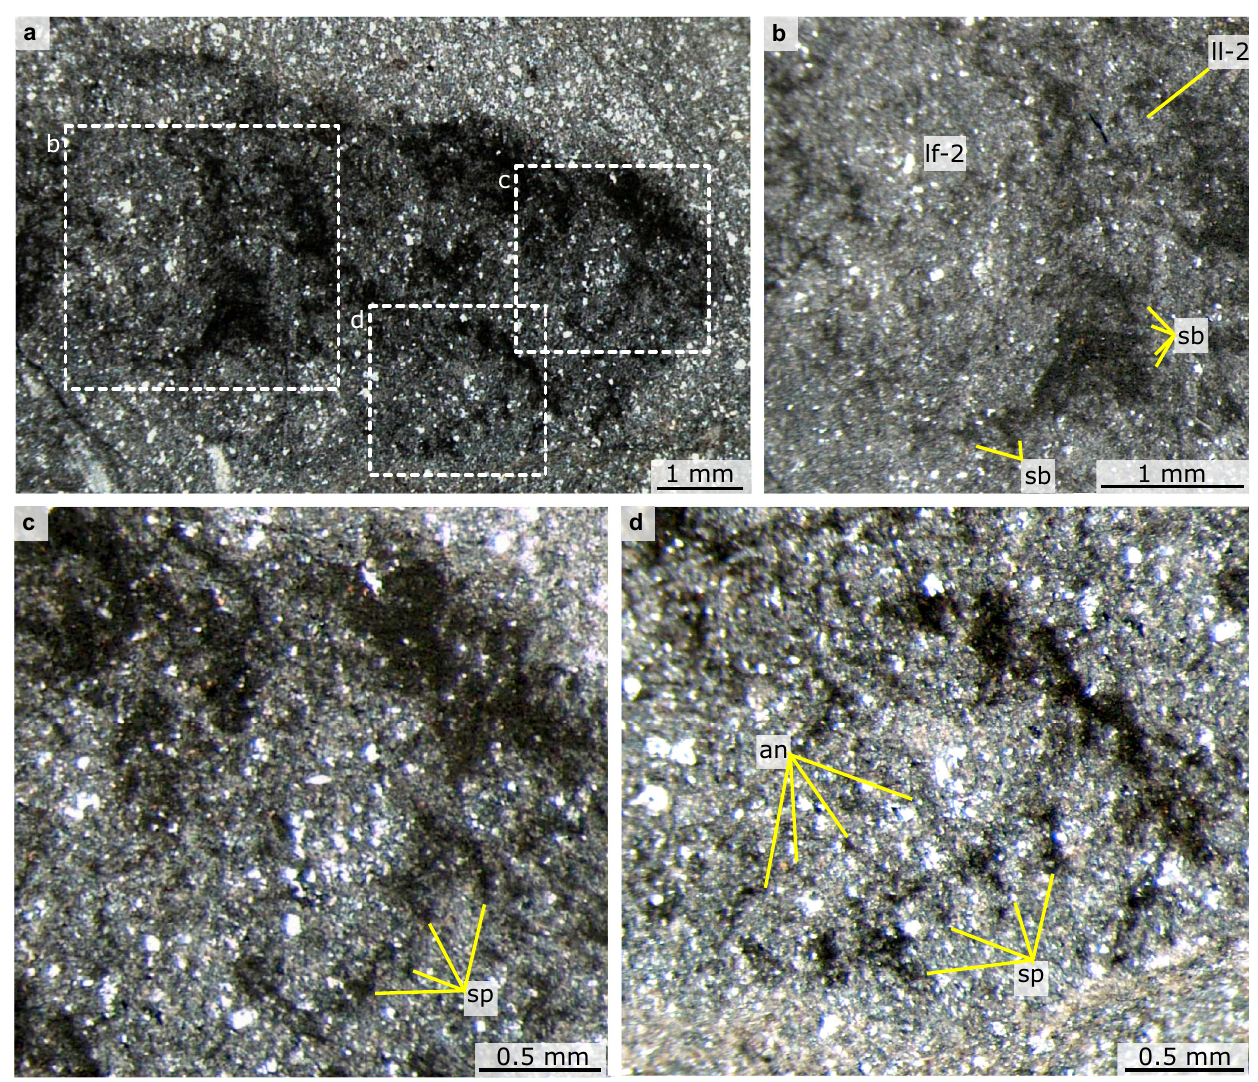
Fig. 5 | Details of trunk of Mieridduryn bonniae nov. gen. et sp. (NMW.2021.3 G.7). a Overview of trunk. b Details of left dorsolateral fl ap and associated setal blades. c , d details of lobopodous limbs with annulations and spines. an